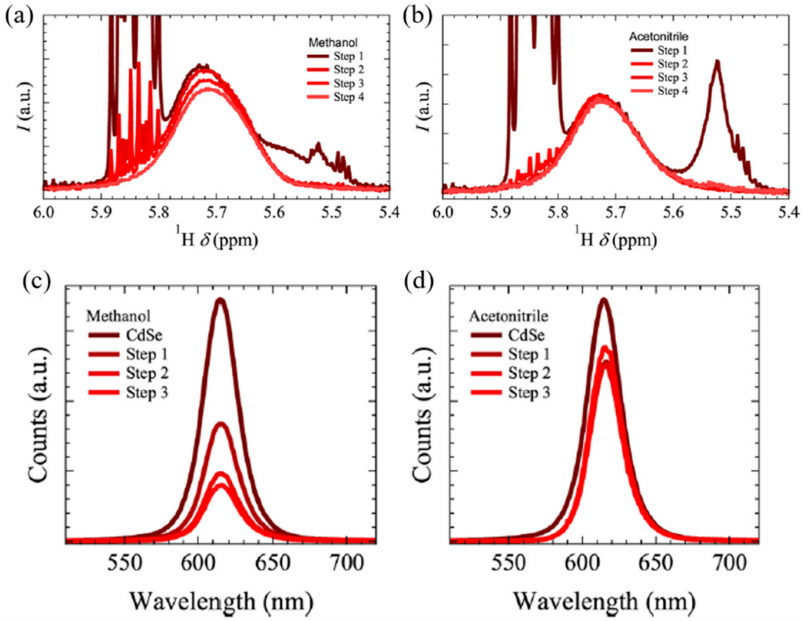
Figure 3. Alkene region of the proton NMR spectra after precipitation/resuspension with ( a ) methanol and ( b ) acetonitrile. Photoluminescence characterization of CdSe QDs after purification with ( c ) methanol and ( d ) acetonitrile. Reprinted with permission from [33]. Copyright 2012, American Chemical